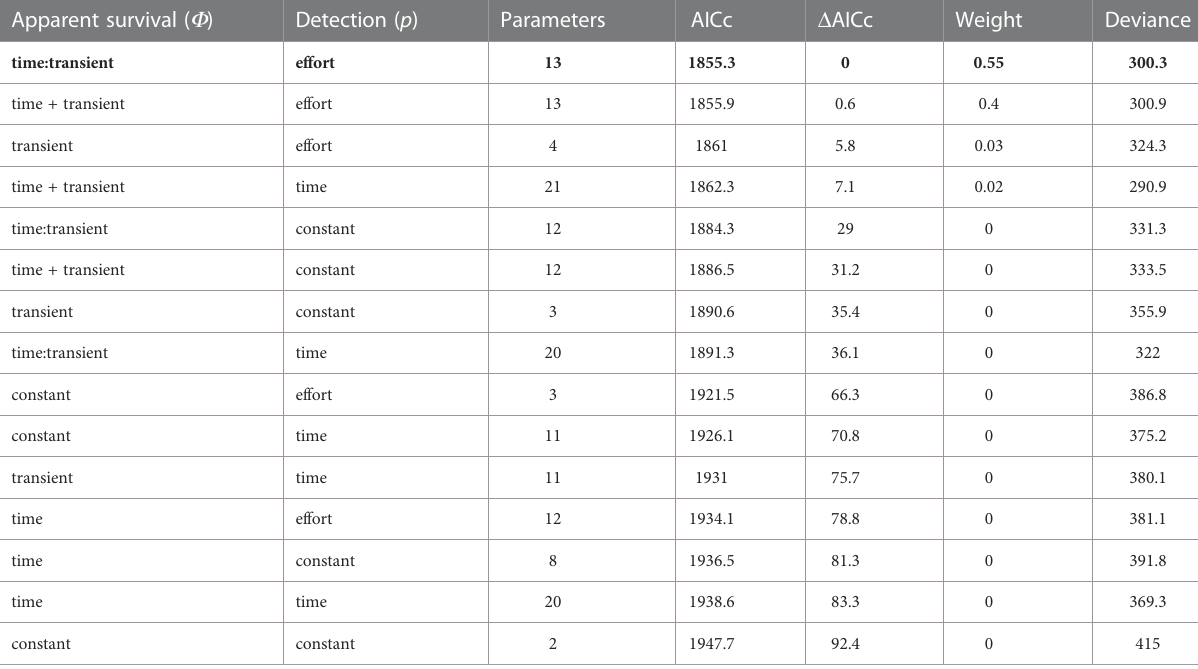
Thebest- fi ttingmodelisinbold.Forapparentsurvival, transient denotesthatsurvivalissplitintotwomodelageclassestoaccountfortransientanimals; transient+time denotesthatthe two survival values are time-varying; and t ime:transient denotes that F 0 is time-varying and F 1+ is constant.